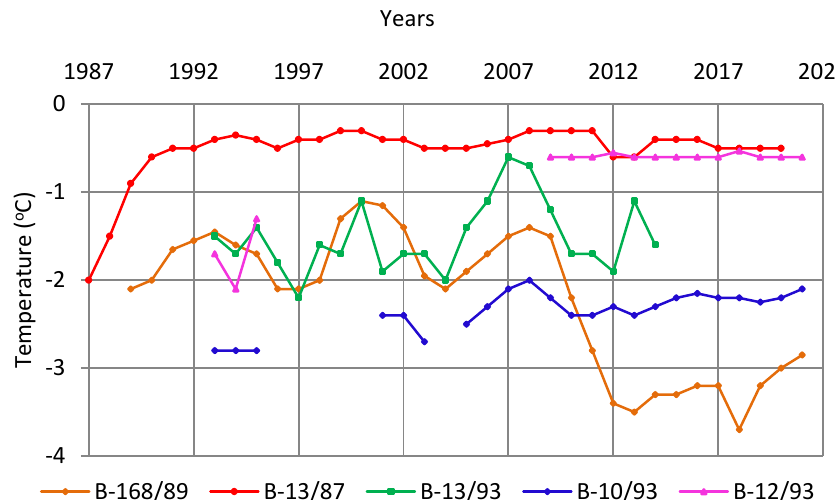
Figure 6. Interannual variations in mean annual ground temperature at a 10 m depth along the water pipeline. B-168/89—forb meadow on a floodplain, B-13/93—pine forest on a sand ridge, B-13/87—burn and cut site on a sand ridge, B-10/93—larch forest in an inter-alas area, B-12/93—cut site in an inter-alas area.